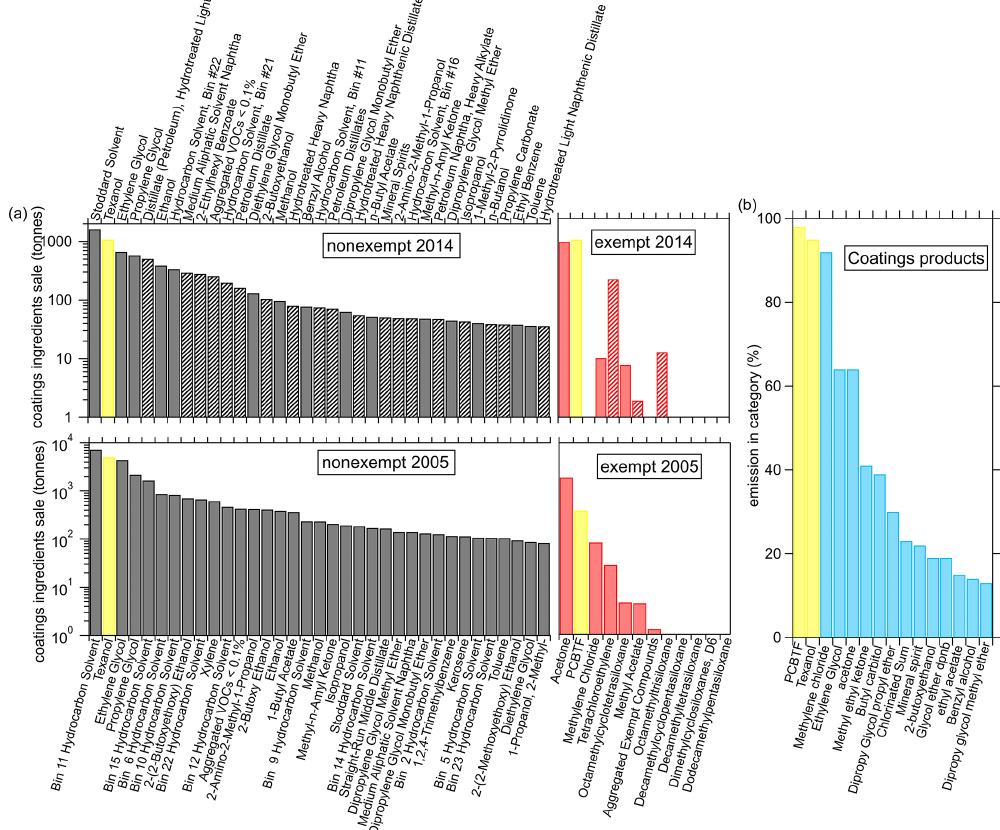
Figure 9. (a) The sale of top 35 nonexempt and exempt VOC ingredients for coatings in 2005 and 2014 in California, together with the (b) fraction of emissions in the coatings category of the 15 highest VOCs as determined by the FIVE-VCP inventory (calculated using the method of McDonald et al., 2018a). The solid bars in the 2014 data indicate compounds that were detected in ambient or product